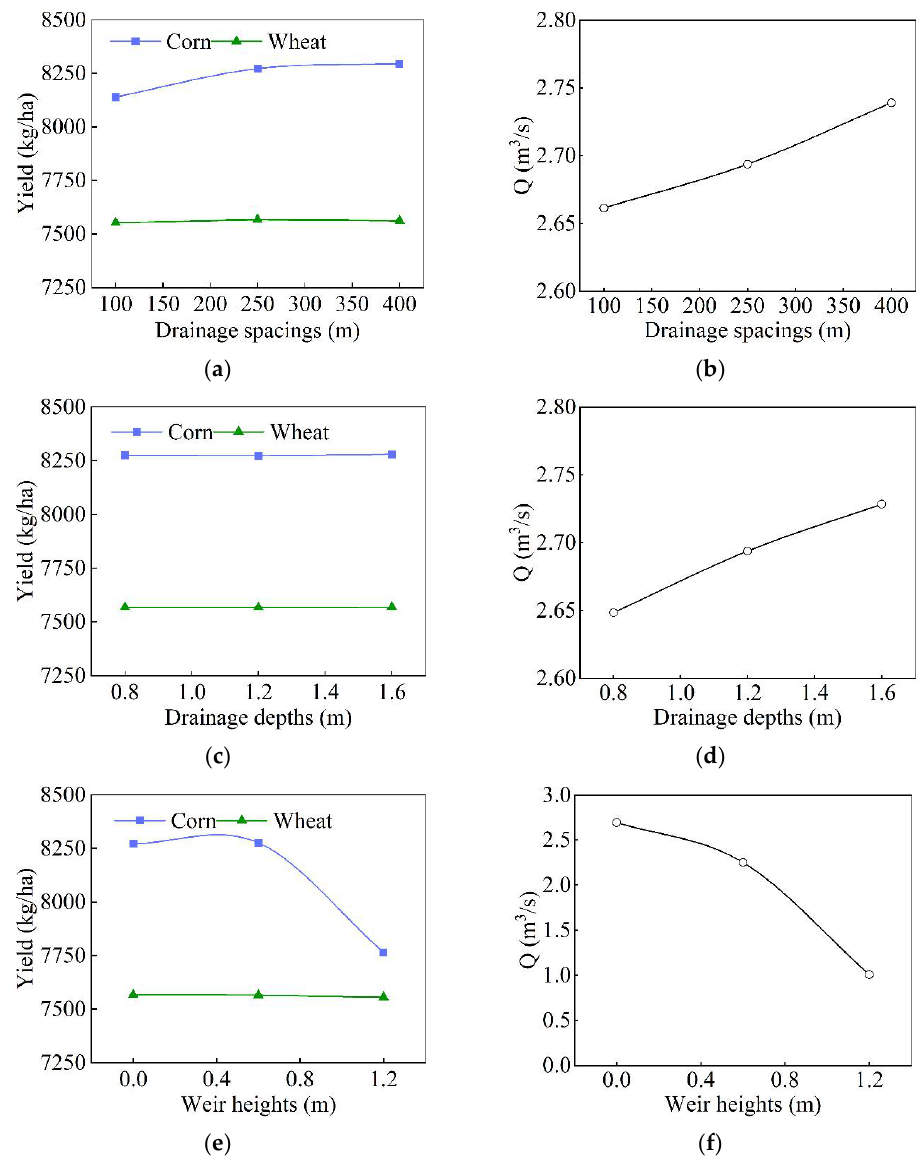
Figure 5. Changes in crop yield and Q under the effect of different field ditch control schemes. ( a , b ) Drainage spacing; ( c , d ) drainage depth; ( e , f ) weir